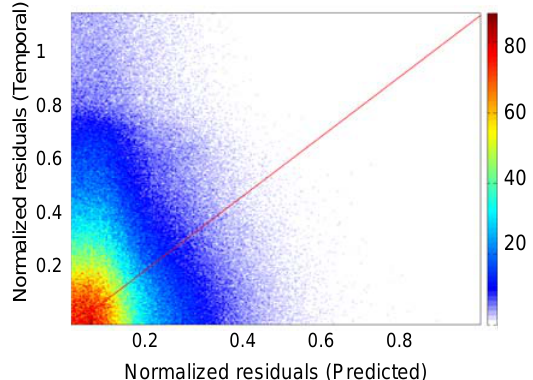
Figure 5. Scatterplot of pixel-level predicted and temporal normalized residuals corresponding to one time step ( k + 1) from the last Landsat observation for the Kansas site (k = DOY 160; k + 1 = 176). The larger number of points above the 1:1 line and the larger range of normalized temporal residuals values indicate that a reliable synthetic NDVI image has been generated. The normalized predicted residuals of 48% of the pixels in the image were below 0.1; 28% between 0.1 and 0.2; 13% between 0.2 and 0.3; 13% between 0.3 and 0.4; and 5% were higher than 0.4.